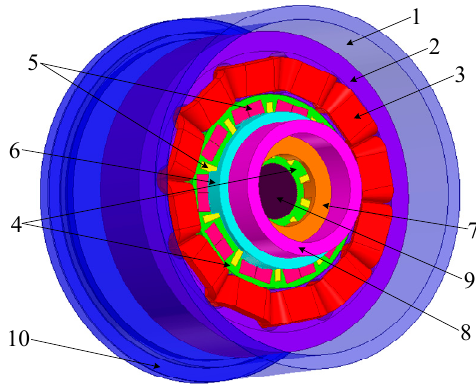
Figure 1. Physical structure of Axial-Radial Flux-Type Permanent Magnet Synchronous Motor (ARFTPMSM). 1-Enclosure, 2-Stator Core, 3-Armature Windings, 4-Rotor Core, 5-Permanent Magnets, 6-Outer Ferromagnetic Ring, 7-Inner Ferromagnetic Ring, 8-Axial Field Windings, 9-Shaft, 10-End Cover.